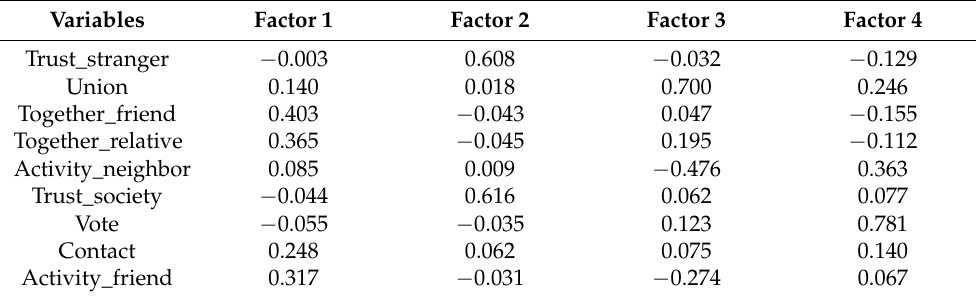
Table A3. Factor Score Coefficient Matrix (1).